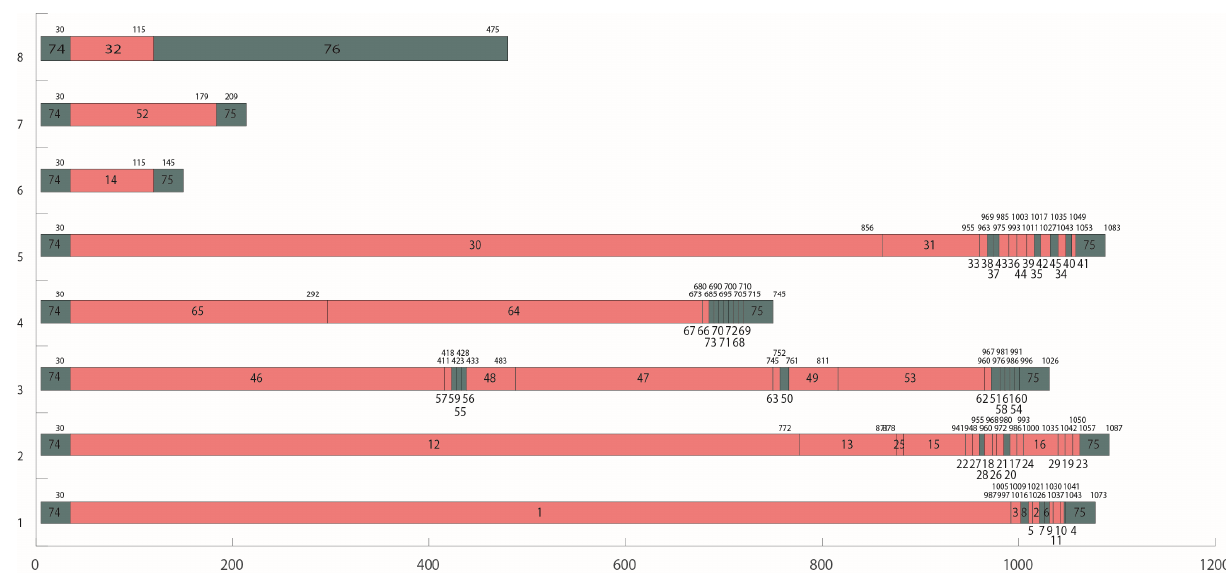
Figure 12. Task assignment Gantt chart for cadence time 1150.